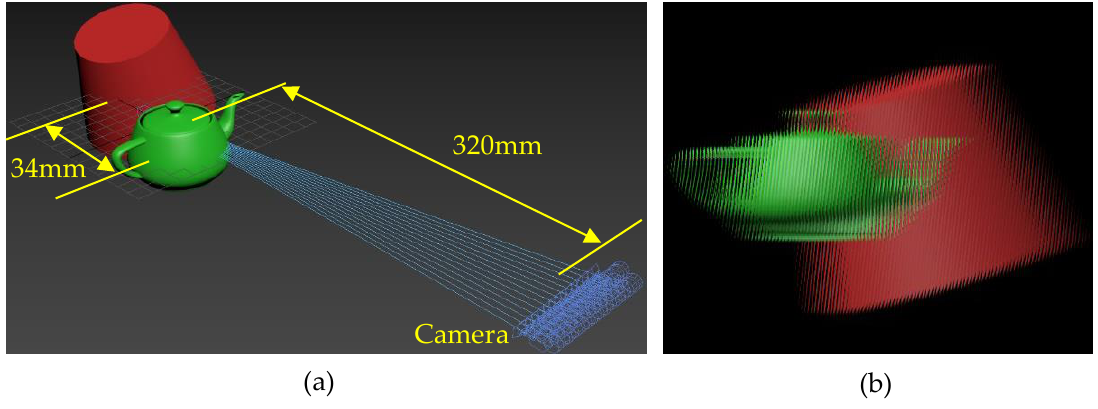
Figure 5. ( a ) Acquisition principle of 3D scene and ( b ) acquired EIA.